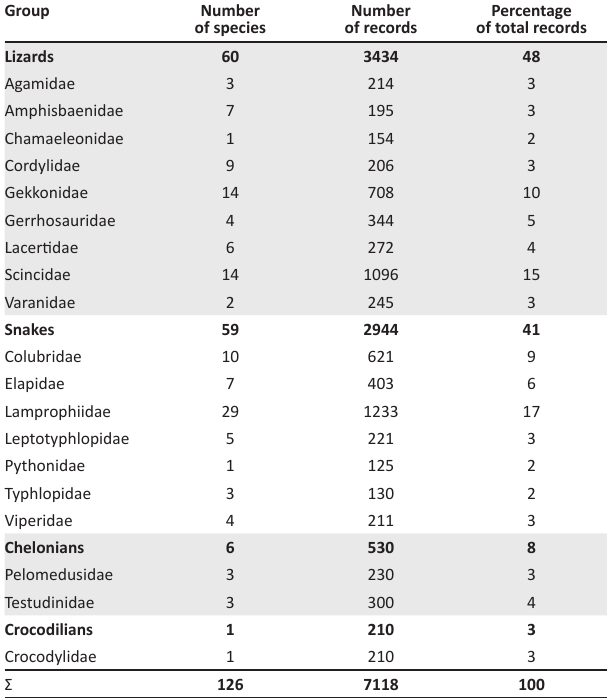
TABLE 2: Summary of records of reptile occurrences within the Kruger National Park.